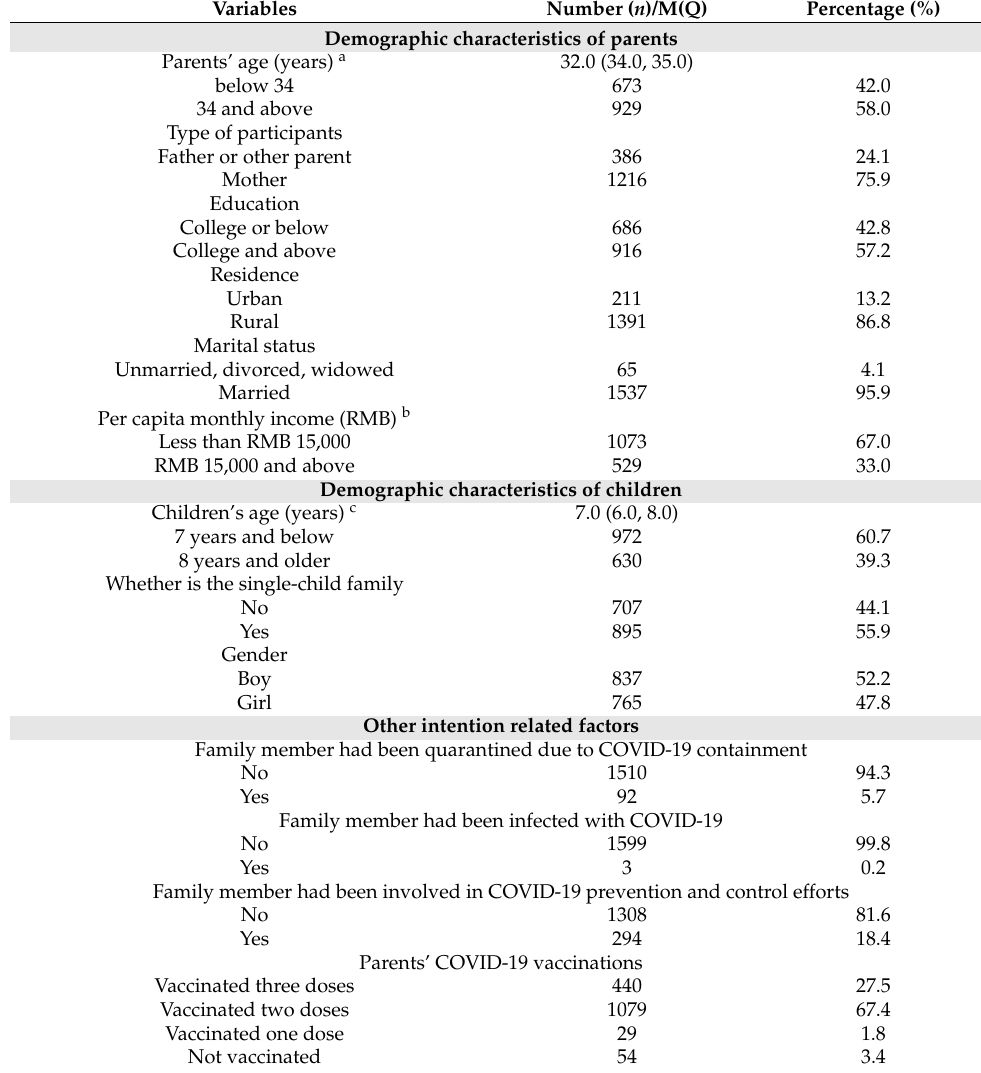
Table 1. Demographic characteristics and other possible factors related to booster vaccination intention ( n =